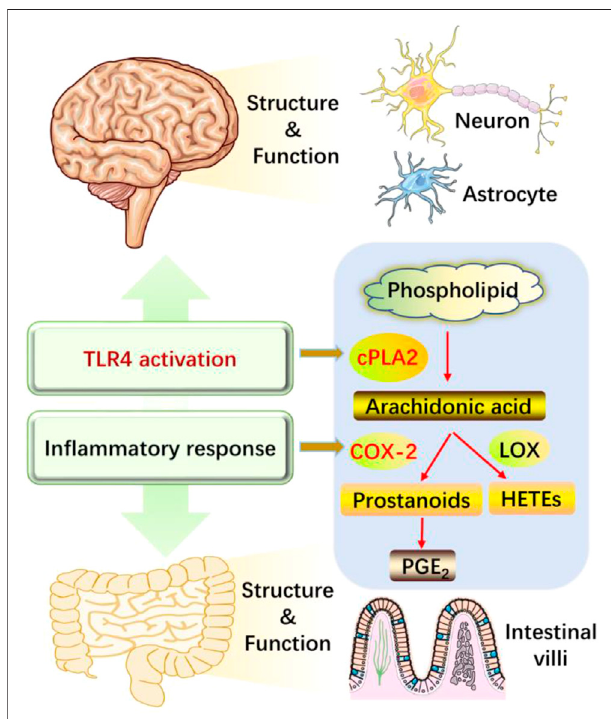
FIGURE8| PuerarinprotectedagainstHFD/CUMS-induceddepression via the TLR4/cPLA2/COX-2 pathway. HFD/CUMS stimulation induced depression-like behavior via increasing in fl ammatory damages. In fl ammatory responseisrelatedtoTLR4activation,inducingthechangesofstructure and function in the brain and small intestine tissues. Puerarin treatment alleviated the depressive phenotype by suppressing TLR4 activation and cytokine over-production, restoring lipid metabolites, inhibiting enzyme activities of cPLA2 and COX-2, and decreasing downstream PGE 2 production. HFD: high-fat diet; CUMS: chronic unpredictable mild stress; TLR4: Toll-like receptor 4; LOX: lipoxygenase; cPLA2: calcium-dependent cytosolic phospholipases A2; COX-2: cyclooxygenase-2; PGE 2 : prostaglandin E 2 ; HETEs: hydroxyeicosatetraenoic